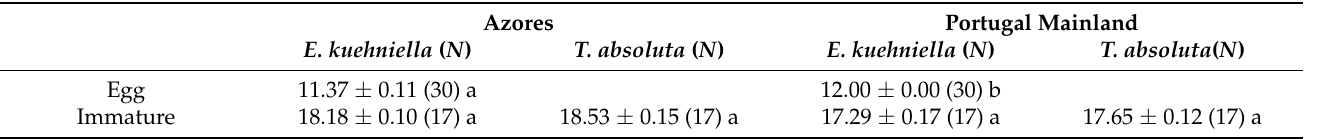
Table 1. Developmental time (days ± SE) of the embryo and immature stages of Macrolophus pygmaeus from the Azorean and Portugal mainland populations fed on single diets of Ephestia kuehniella or Tuta